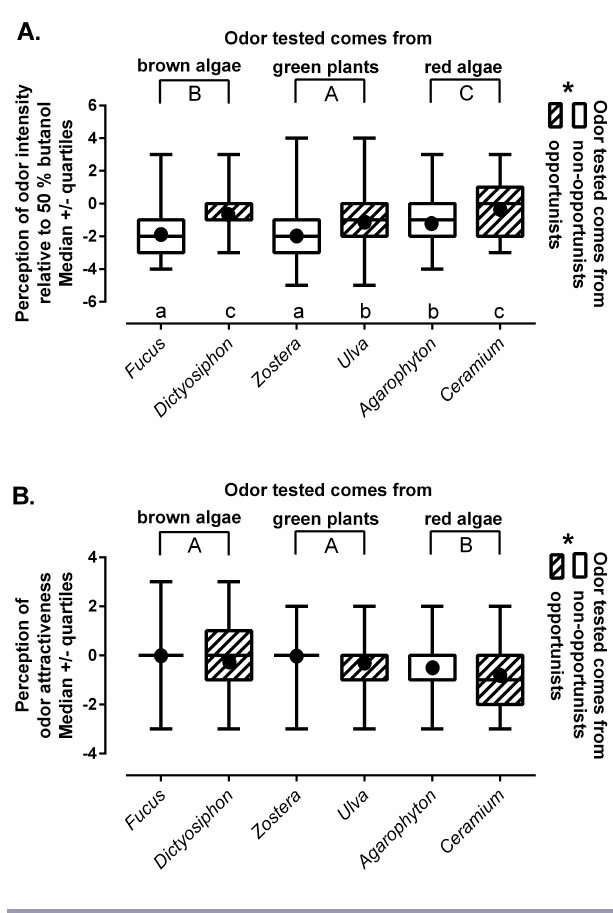
Fig. 4 . Perception of (A) intensity and (B) pleasantness of odor from six decaying macrophytes. Boxes with whiskers indicate medians and quartiles, while dots indicate arithmetic means. Asterisks, different capitals and different letters indicate treatments that were statistically different in a repeated- measures-2-way-ANOVA (p < 0.05 in (A) and p < 0.01 in (B), see also Tables S5 and